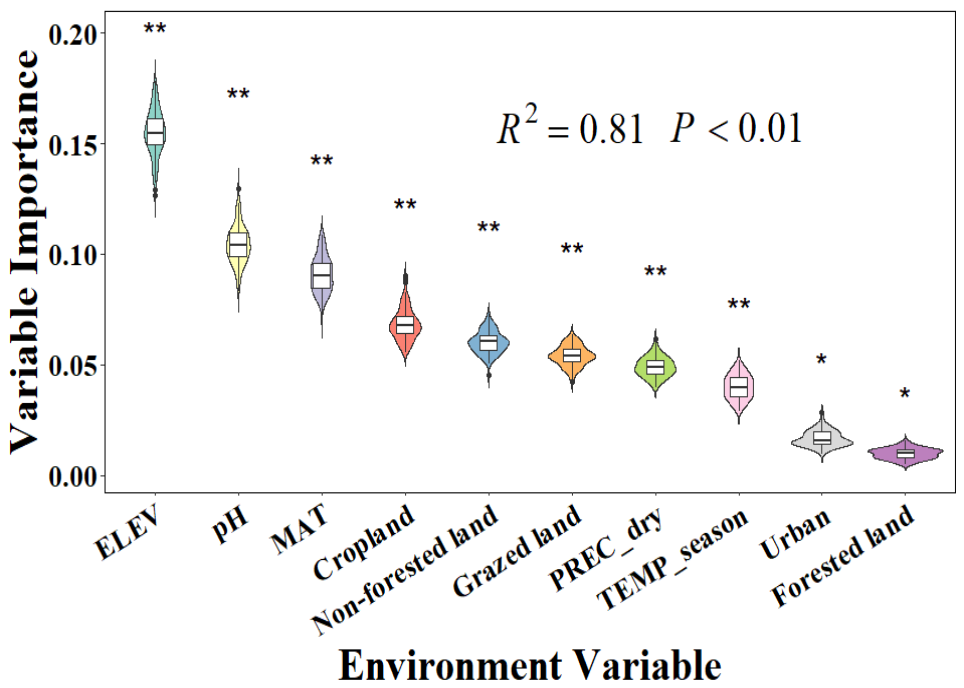
Figure 5. The relative importance of environmental predictors for the wild apple distributions.